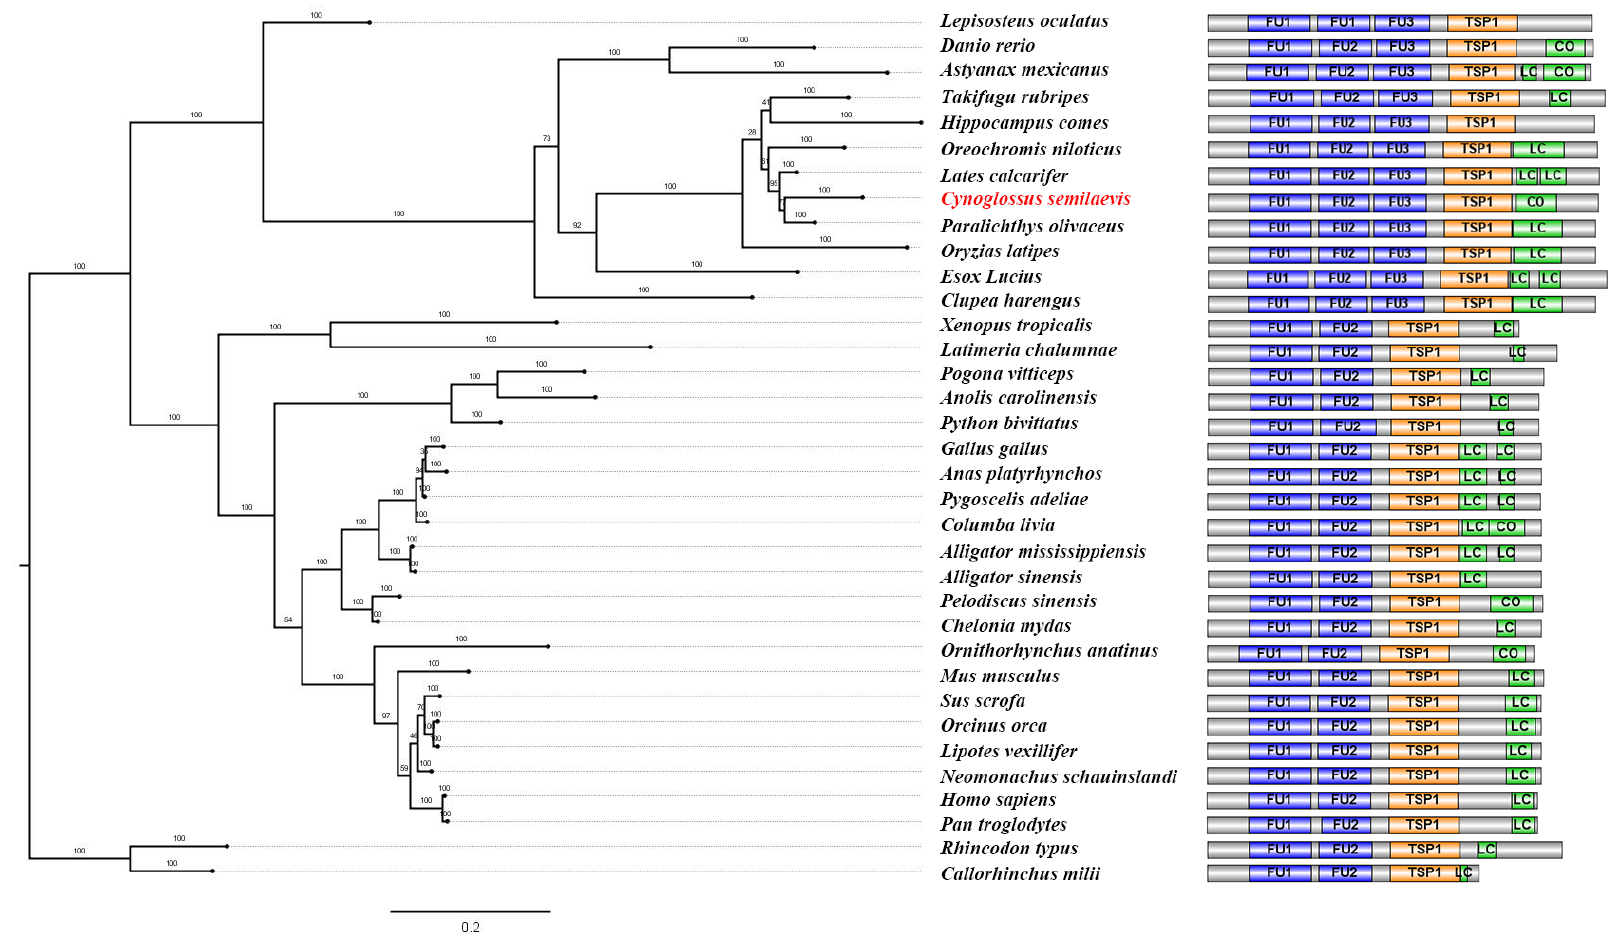
Figure 2. Phylogenetic and protein structure analysis of C. semilaevis and other vertebrate Rspo3 /RSPO3 orthologs. The phylogenetic tree was constructed by MrBayes software, the lengths of the branches represent genetic distances, and bootstrap percentages are shown as numbers on the branches. The accession numbers are shown in the methods section. The protein structure is shown following the corresponding phylogenetic branch. FU: cysteine-rich furin-like domain; TSP1: thrombospondin-type1 domain; LC: low compositional complexity; Co: coiled coil region.